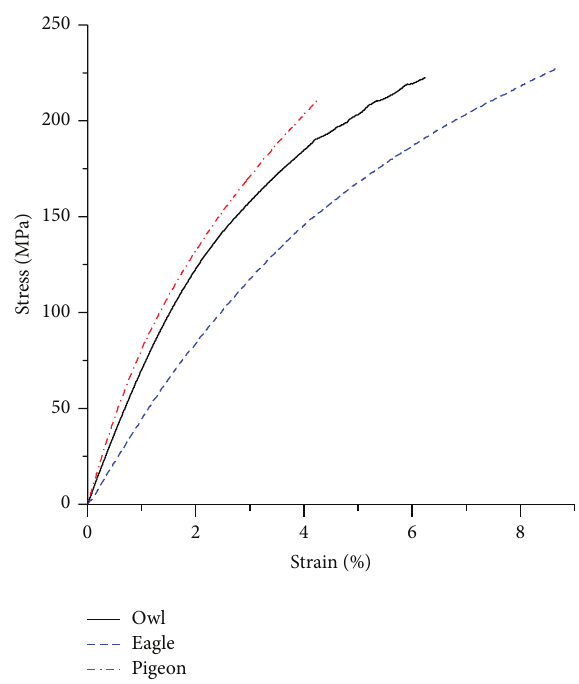
Figure 5: Relationships of the stress and strain for long-eared owl and pigeon